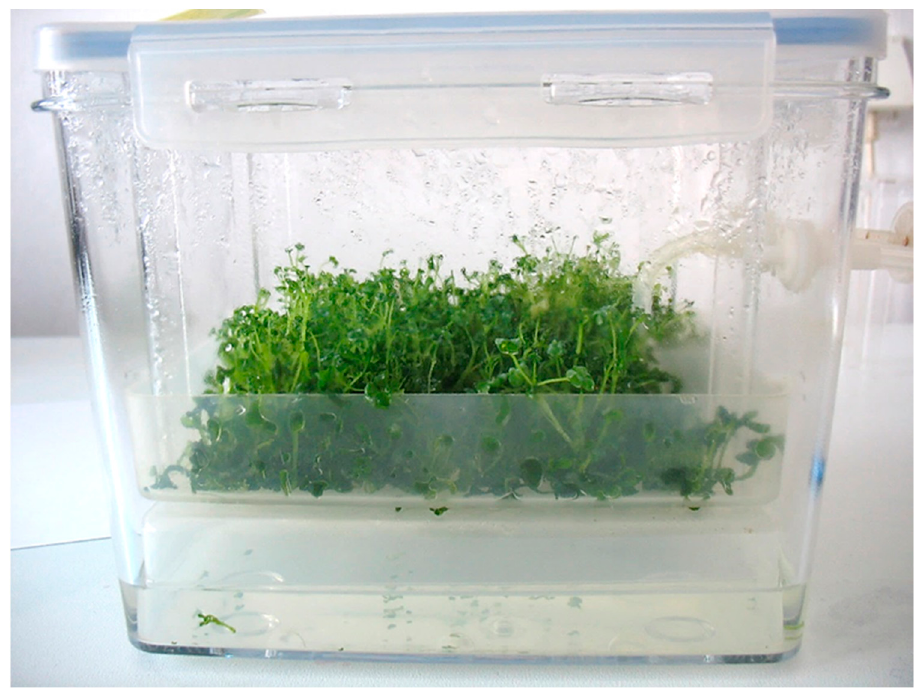
Figure 1. Ruta montana bioreactor culture (LS NAA/BAP 0.1/0.1 mg/L, 5-week growth cycle). Table 1. The dry weight (DW) [g] obtained from R. montana bioreactor cultures for different growth cycle and LS medium variants. LS Medium Variant NAA/BAP